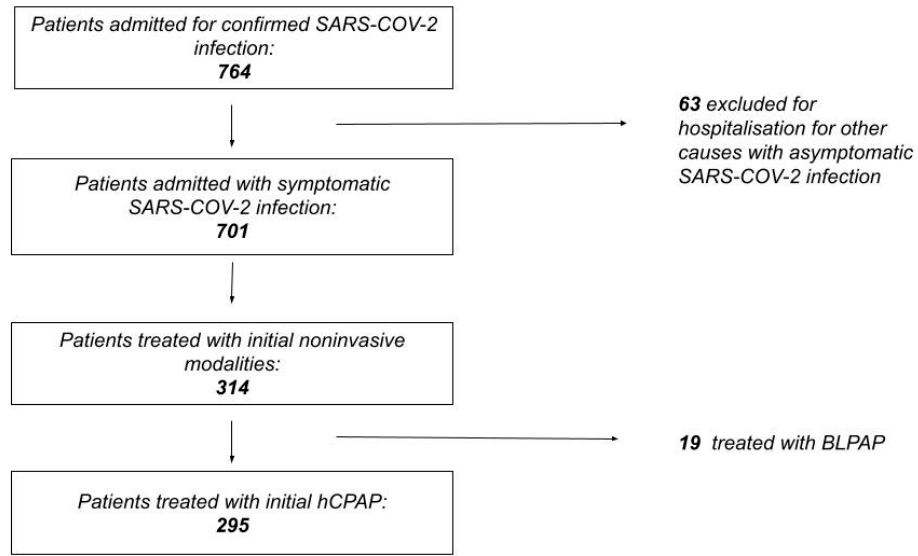
Figure 2. Flow diagram rendering the process of patient selection.